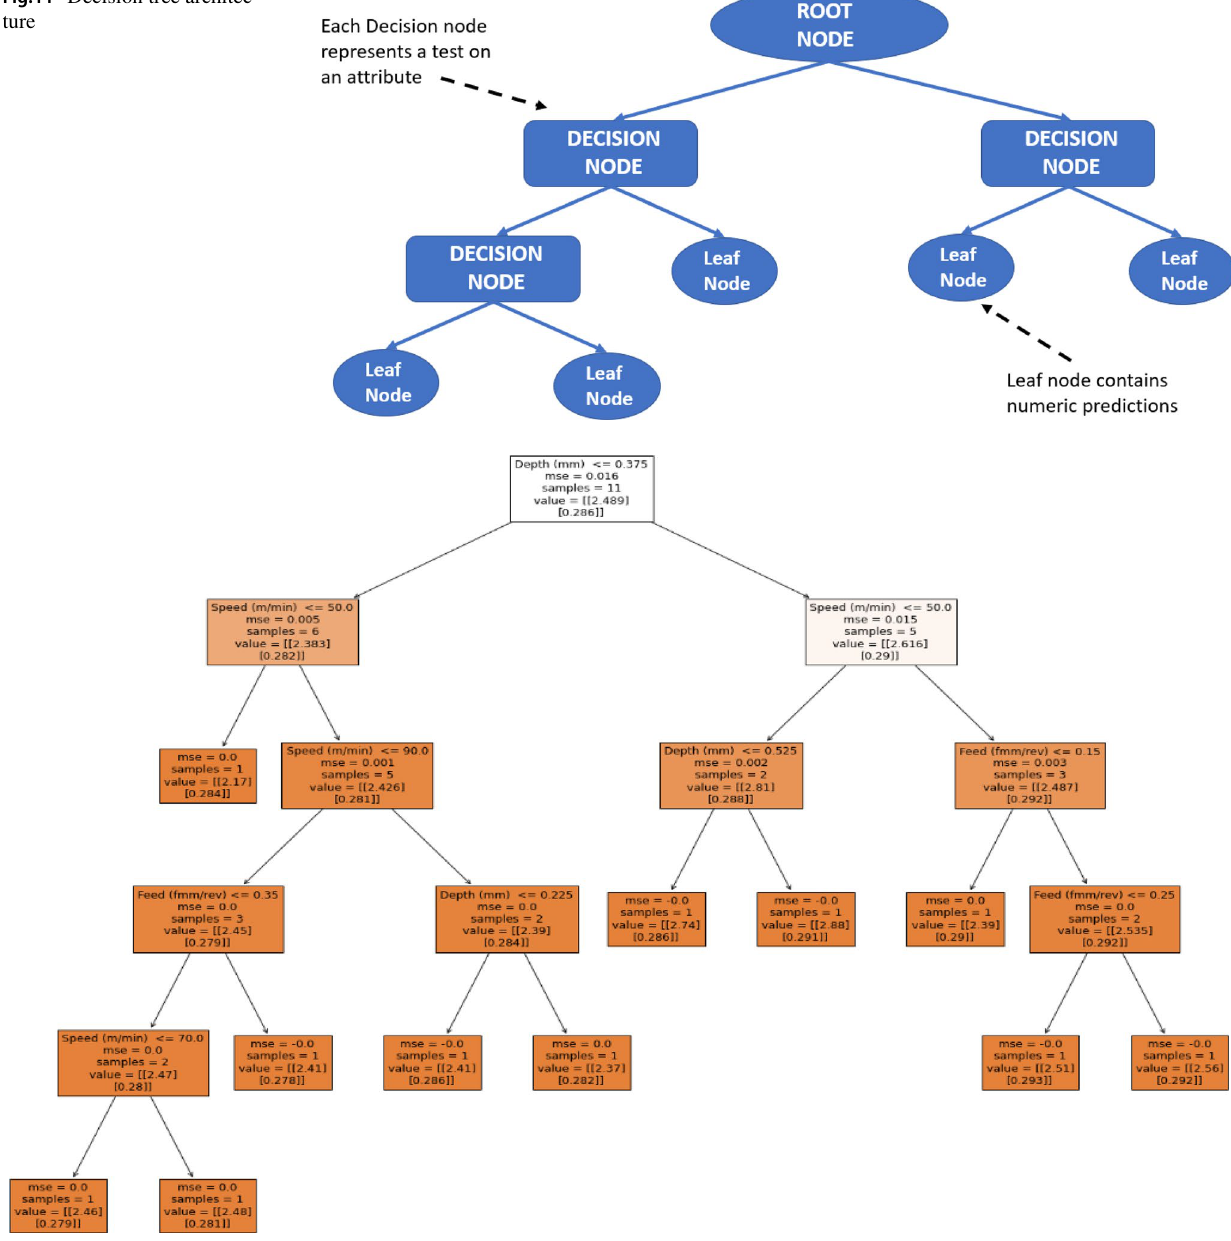
Fig. 12 Decision